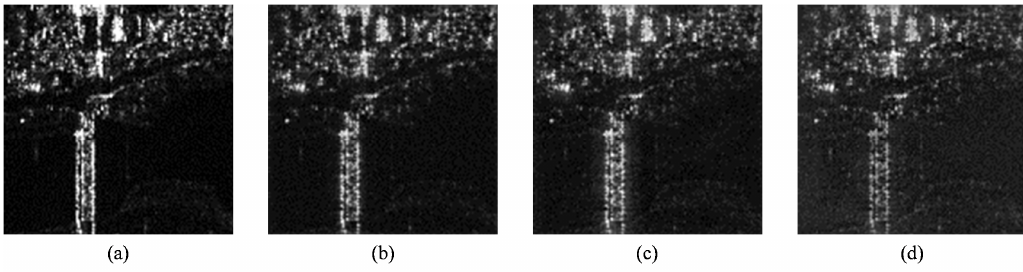
Figure 7. Training results of reconstruction pathway (source task). ( a ) the input image; ( b – d ) the reconstruction images of the 1st, 3rd, and 5th convolutional layer,